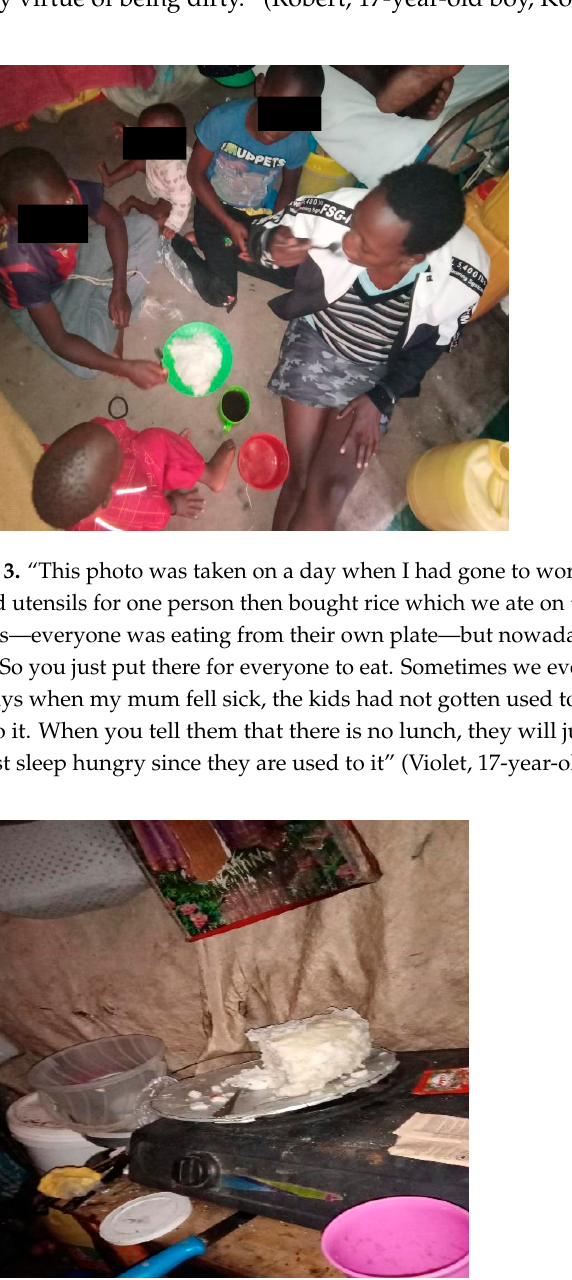
Figure 4. “We had that ugali but had nothing like vegetables to eat it with…and sometimes we have the vegetables with no money for flour” (Paula, 17-year-old girl, Viwandani).